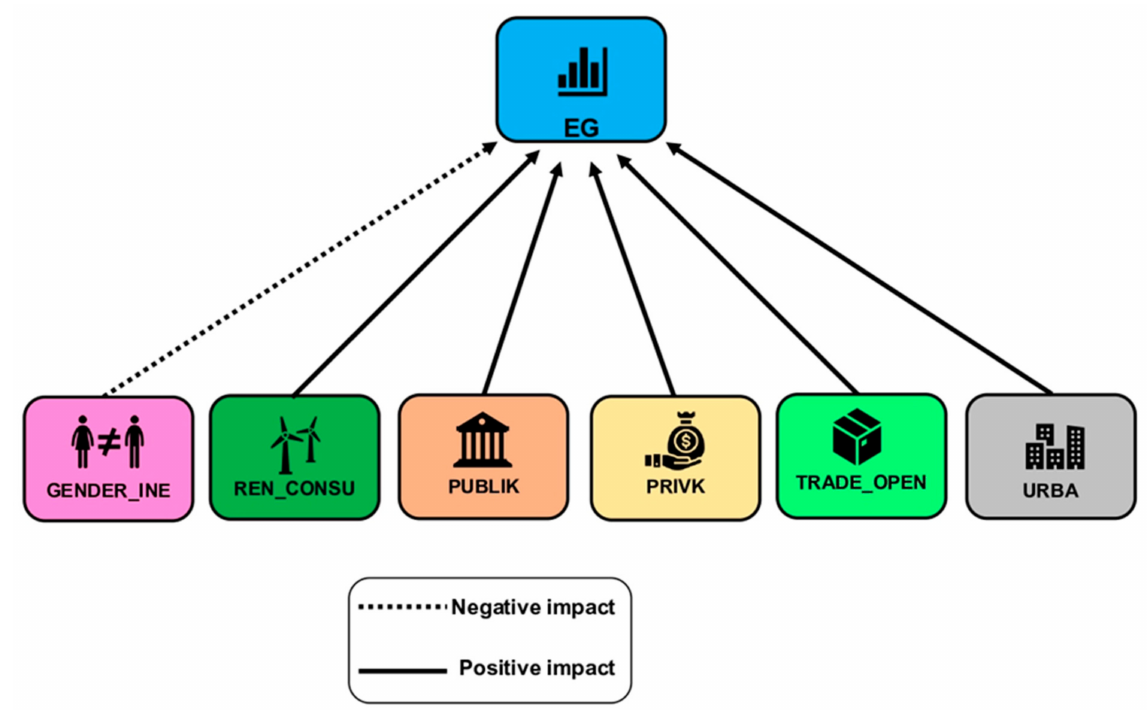
Figure 3. Summary of the variables’ effects. The authors created this